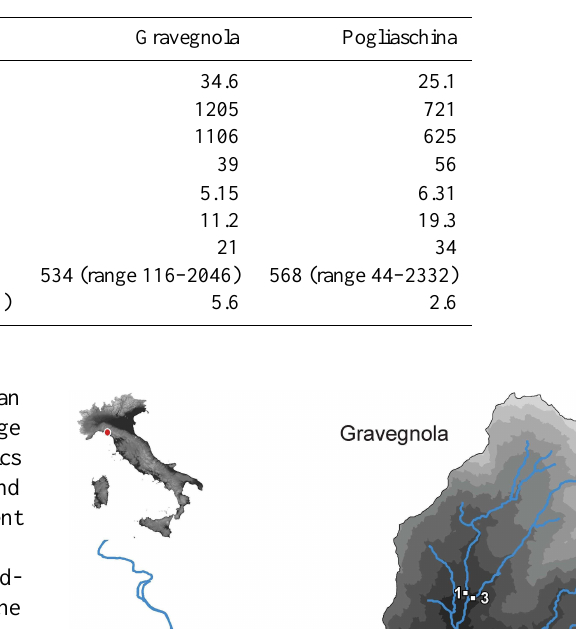
Table 1. Main characteristics of the studied catchments.